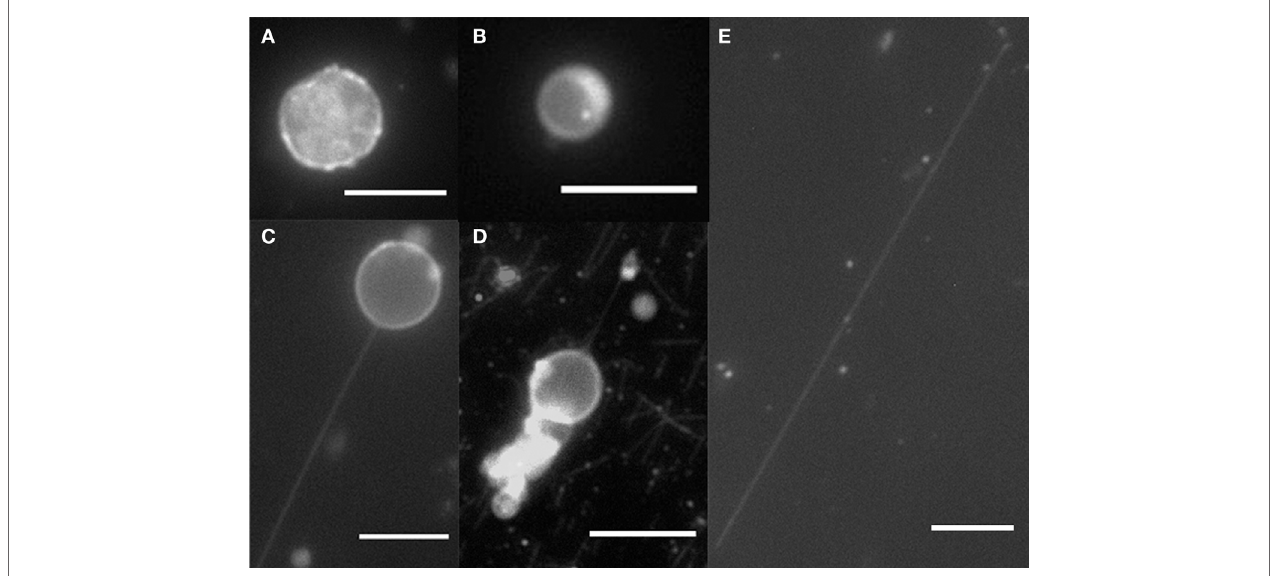
FigUre 2 | Fluorescence microscopy of gUVs and nanotubes . (a) DPPC/DGS-NTA (5 mol%) crumple vesicle, (B) DOPC/DGS-NTA (5 mol%) vesicle, (c) DOPC/DGS-NTA (5 mol%) tethered GUV, (D) DOPC/DGS-NTA (5 mol%) tethered GUV with labeled microtubules, and (e) DOPC/DGS-NTA (5 mol%) lipid nanotube. Scale bar: 10 μ